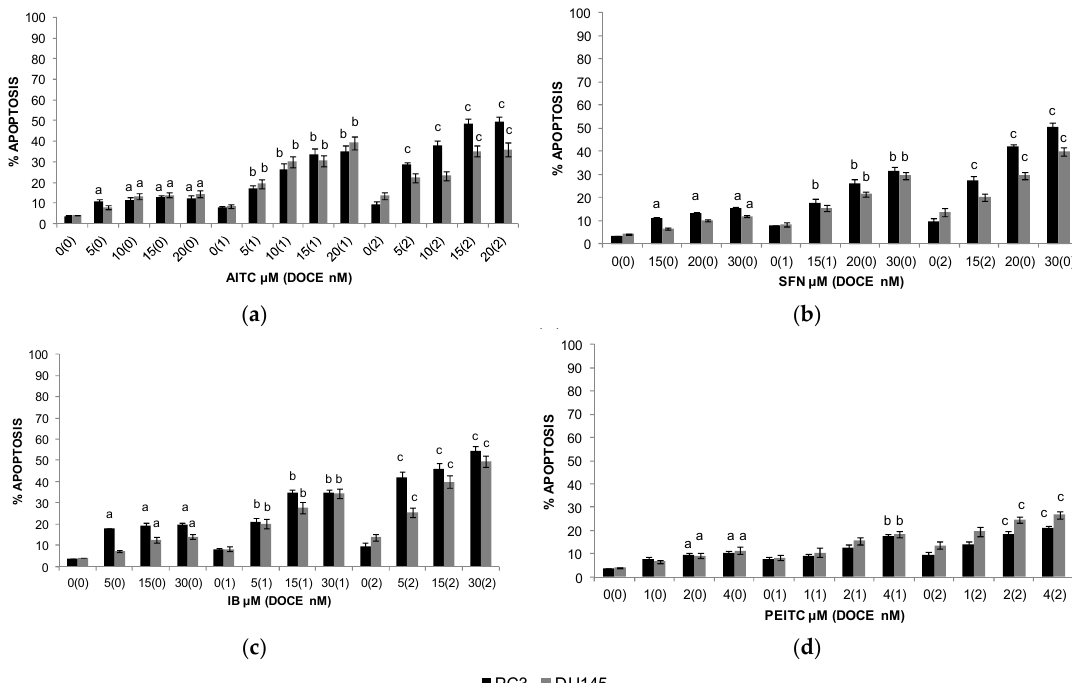
Figure 3. Quantitation of apoptotic PC-3 (black pillar) and DU 145 (grey pillar) cells (DAPI assay) following 72 h treatment with allyl-isothiocyanate (AITC) ( a ), sulforaphane (SFN) ( b ), iberin (IB) ( c ), phenethyl-isothiocyanate (PEITC) ( d ), and / or docetaxel (DOCE). Data are shown as the mean ± SD of three independent experiments. a , p < 0.05, ITC (isothiocyanate) treatment alone significantly di ff erent compared with control treatment; b , p < 0.05, combination treatment (ITC + DOCE 1 nM) significantly di ff erent compared with low-dose DOCE alone; c , p < 0.05, combination treatment (ITC + DOCE 2 nM) significantly di ff erent compared with high-dose DOCE alone (one-way ANOVA).